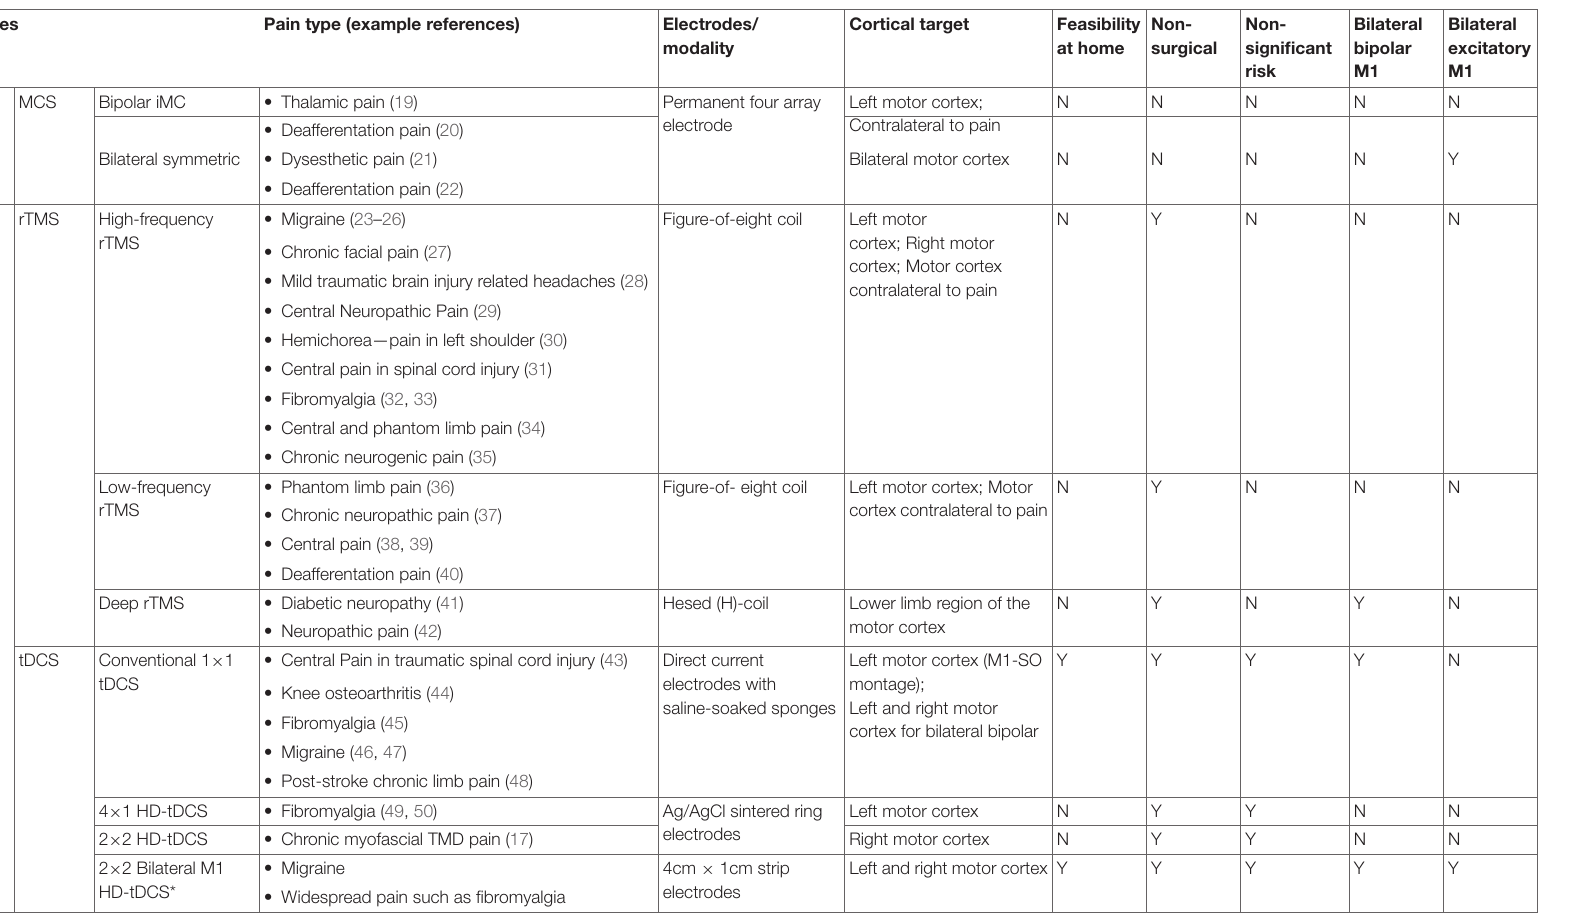
HD, high-definition; iMC, ipsilateral motor cortex; MCS, motor cortex stimulation; M1-SO, primary motor cortex and contralateral supraorbital area; rTMS, repetitive transcranial magnetic stimulation; tDCS, transcranial direct current stimulation. * Proposed home-based non-invasive HD-tDCS montage for bilateral M1